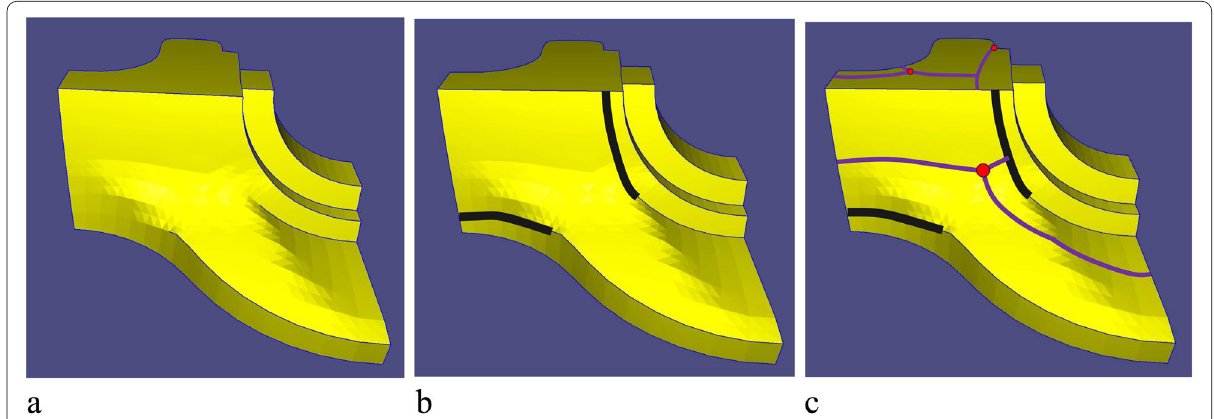
Fig. 11 Information on clipping edges. a Priorities 1, 2, and 3; b Priority 4 (black curve); c Priority 5 (purple